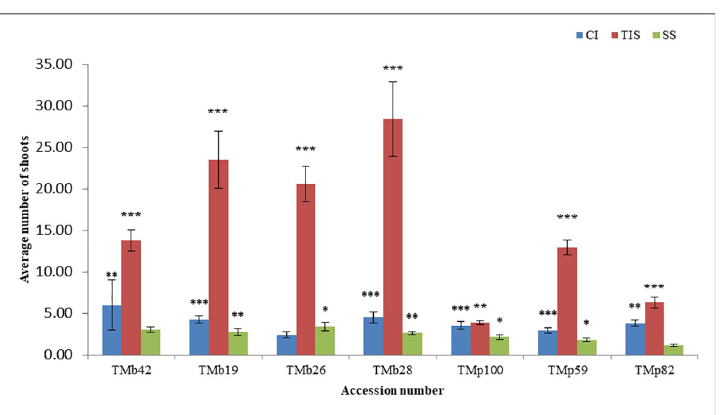
Fig 1. Effect of culture systems on Musa spp. under in vitro conditions. CI: Complete Immersion. TIS: Temporary Immersion System. SS: Semi-Solid.